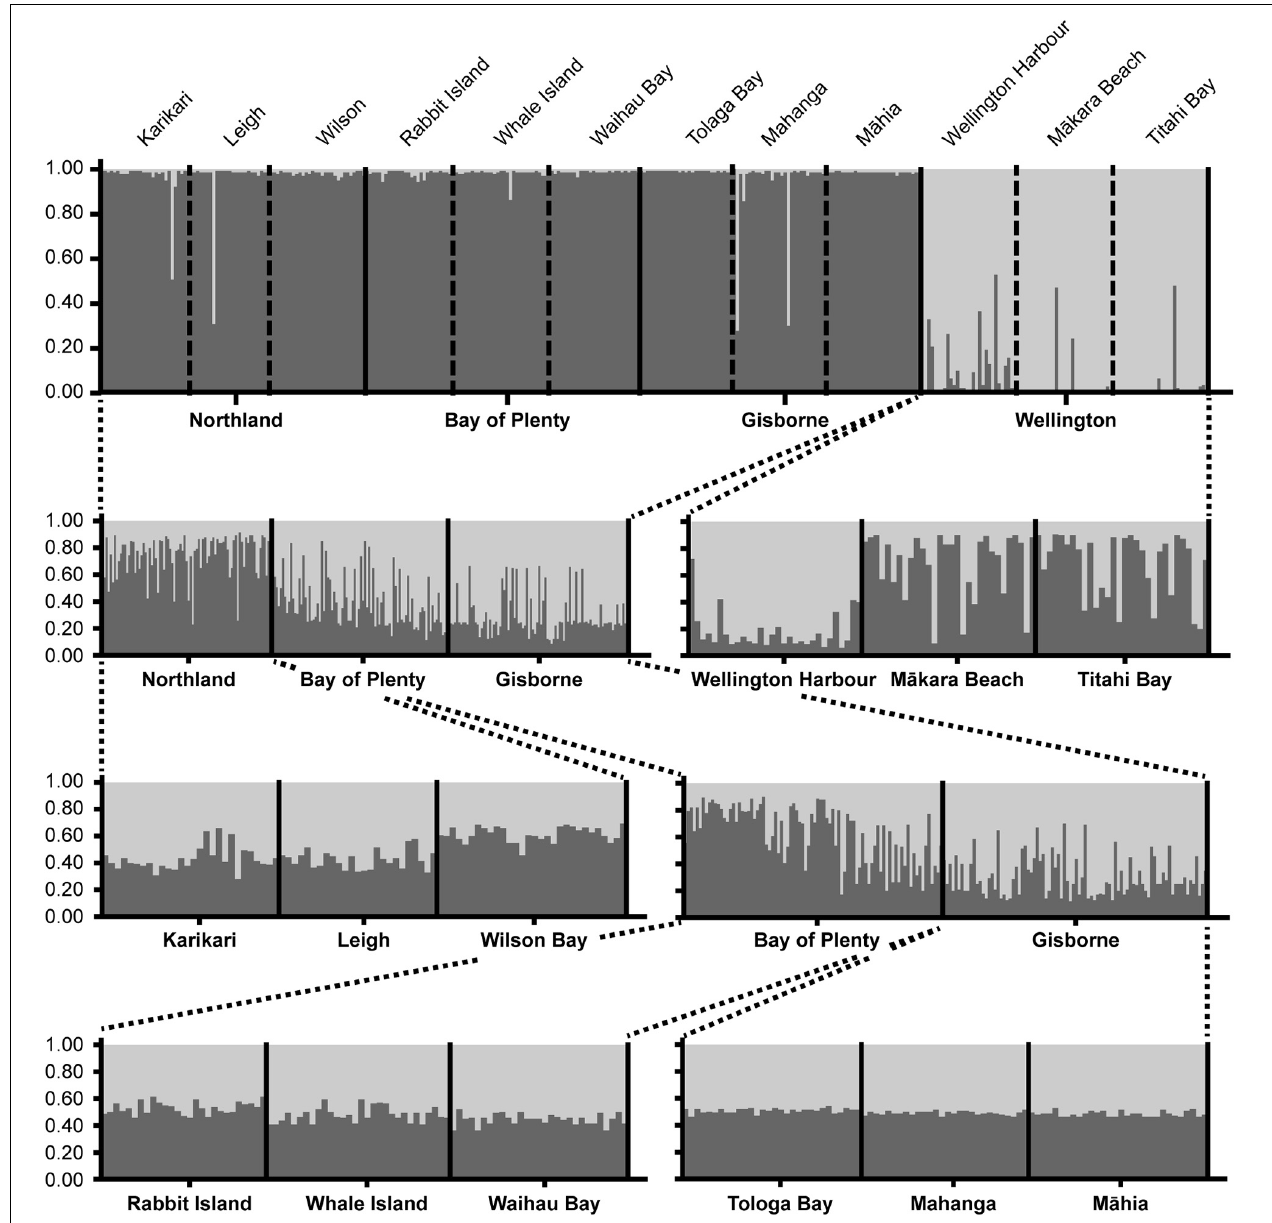
FIGURE 3 | Bayesian modeling of population structure for E. radiata obtained using STRUCTURE ( K = 2 for all plots). Top plot was run with all samples included and each subplot underneath was run with a subset of the samples indicated by the dashed lines. The x -axes show all individuals included in the simulations, with each individual represented by a column and grouped within their sites and regions. The y-axes show the genetic membership of each individual to the two